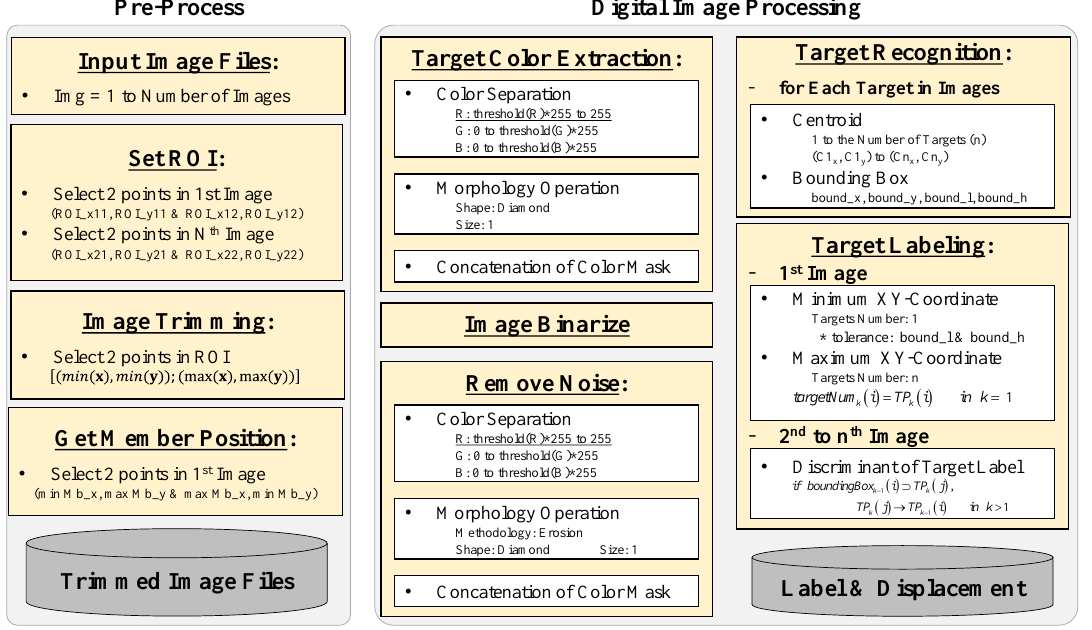
Figure 2. Digital image processing (DIP) algorithm for tracking point (TP) displacement tracking.